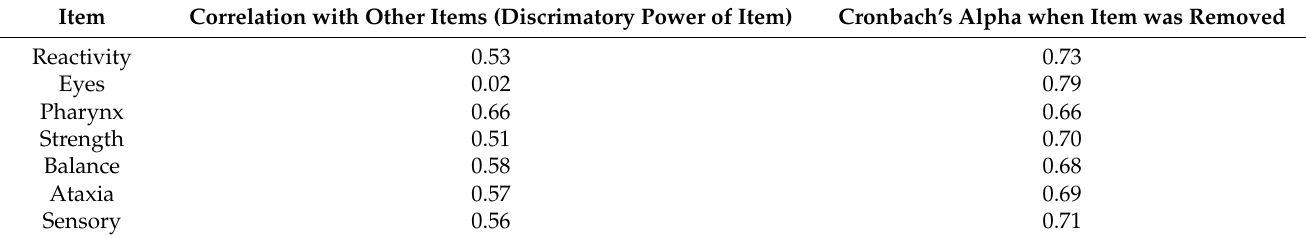
Table 3. Selected psychometric properties of individual items in Adam’s Scale of Posterior Stroke (ASPOS).